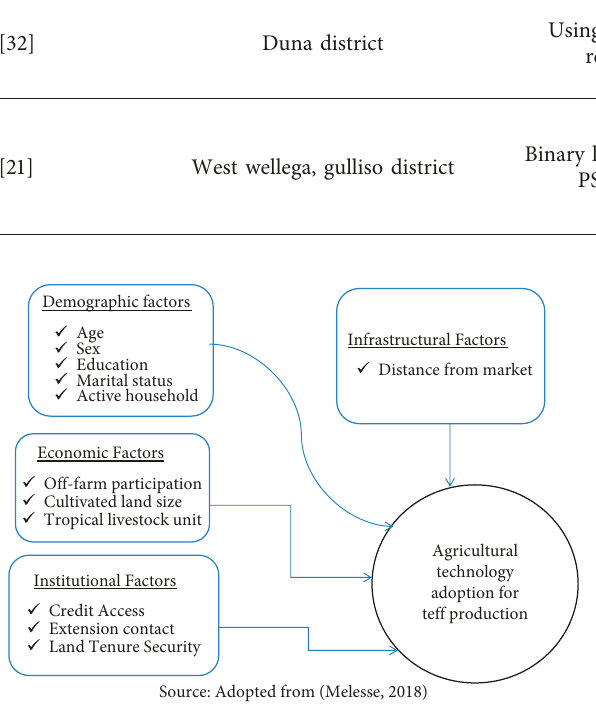
Figure 1: Conceptual framework. Source: adopted